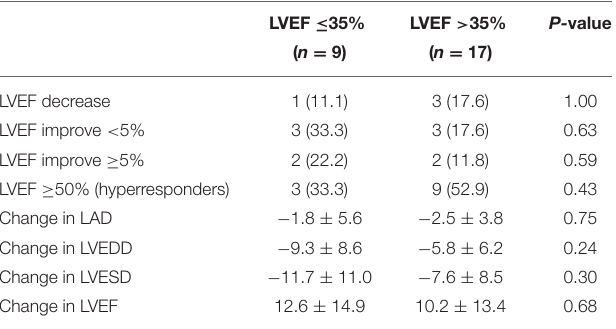
TABLE 4 | LBBAP response and clinical outcomes at 6-month